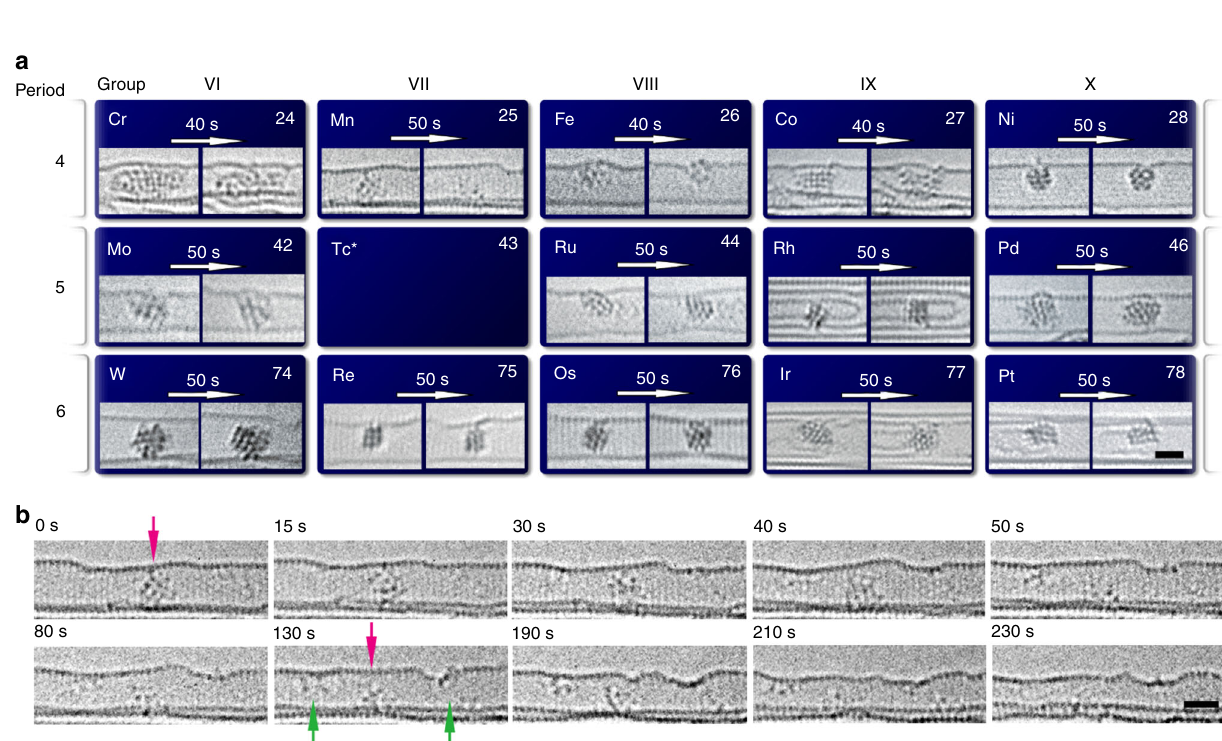
Fig. 2 Dynamic behaviour of 14 metal nanoclusters under e-beam irradiation. a Typical examples of 80 keV AC-HRTEM images of 14 transition metal nanoclusters in carbon nanotubes, showing their structural transformations after 40-50 s of electron irradiation. b Time-series images of a Mn nanocrystal breaking down to individual atoms under the electron beam. The intact Mn nanocrystal (indicated by a magenta arrow in the 0 s frame) gradually breaks up into smaller clusters (indicated by green arrows in the 130 s frame) and single atoms during continuous irradiation for 230 s. *Tc is a rare radioactive element, which was not studied in this work. The scale bar is 1